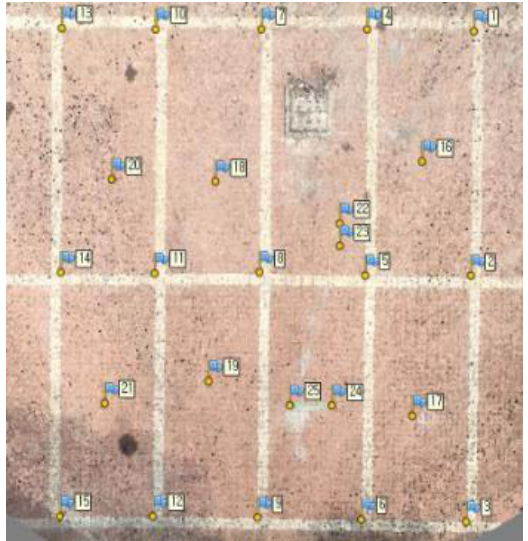
Figure 4. Experiment area & distribution of GCP